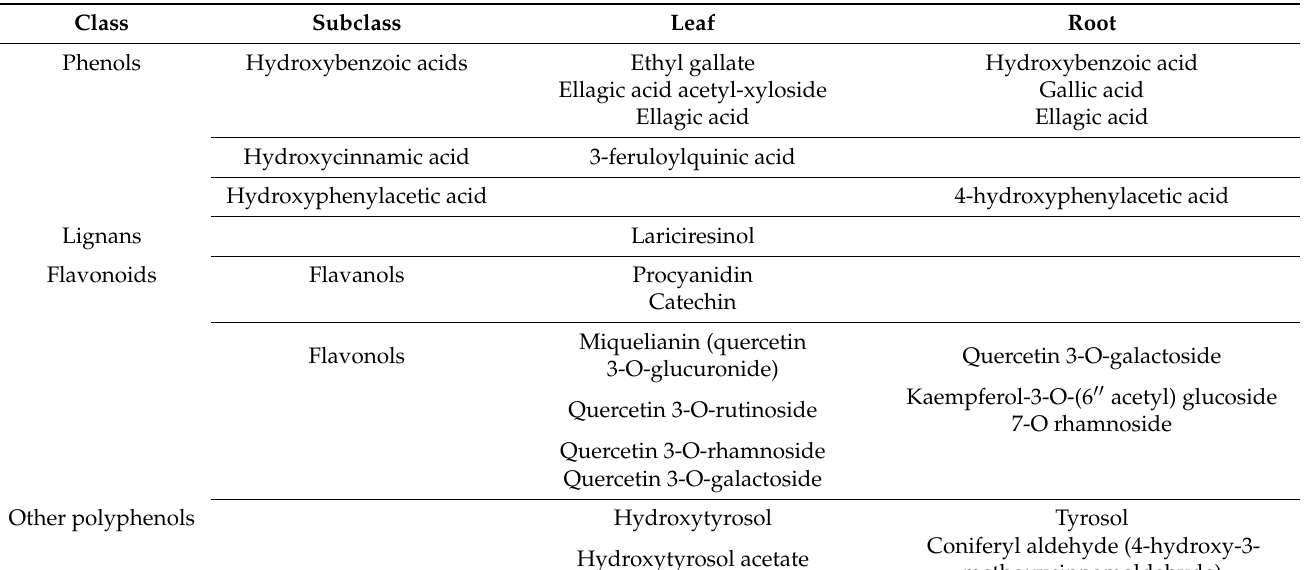
Table 1. Secondary metabolite compounds detected, identified and quantified in leaves and roots of six-month-old Castanea sativa